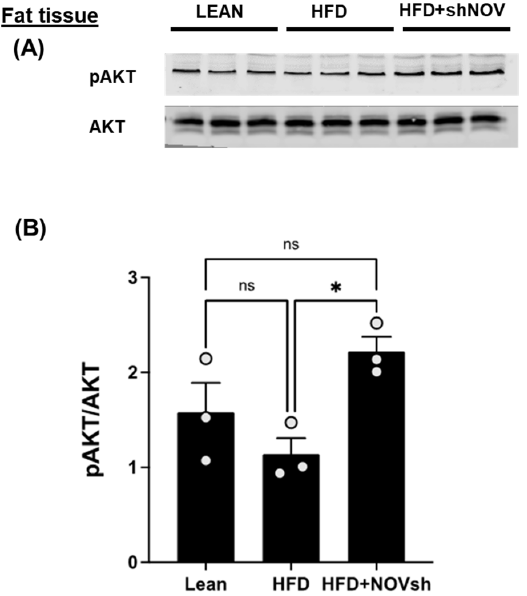
Figure 8. In vivo silencing of NOV with shNOV treatment (NOV knockdown) improves metabolic markers in adipose tissue. Representative western blot of pAKT and AKT (protein kinase B)( A ), and corresponding quantification of the pAKT/AKT ratio ( B ) in the adipose tissue of lean, high-fat, and shNOV mice. Results are means ± SE; * p < 0.05, ns = not significant.